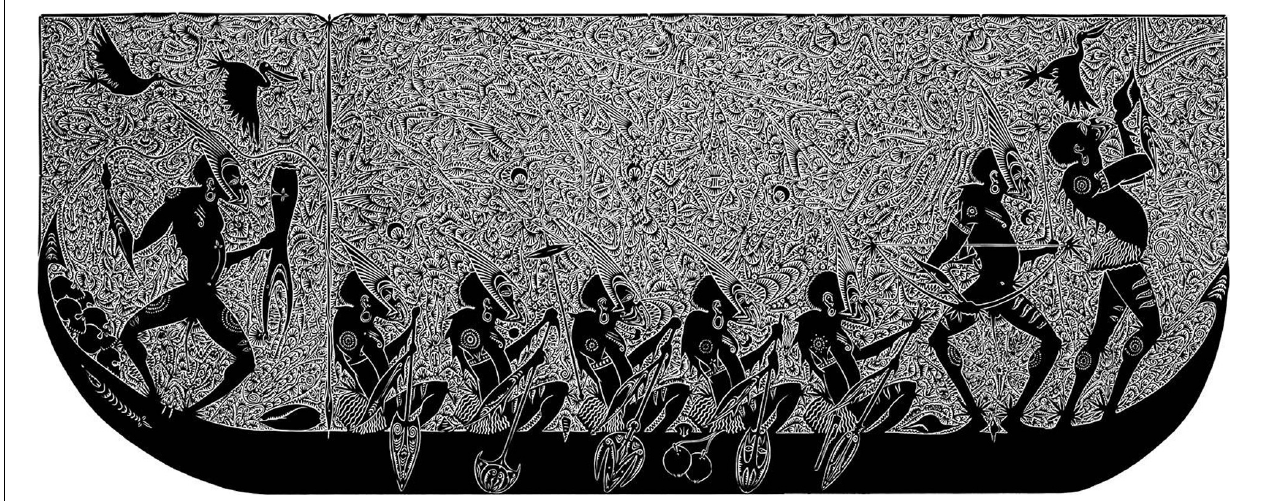
FIGURE 3 | Australian Indigenous Art: this linocut called “Zugubak” was created in 2006 by Alick Tipoti from the Torres Strait Islands, Queensland, Australia. The masterpiece depicts a canoe carrying eight men through the ocean by night. These men are the Zugubal spiritual beings of the Western Zenadh Kes (Torres Strait). Courtesy Alick Tipoti /